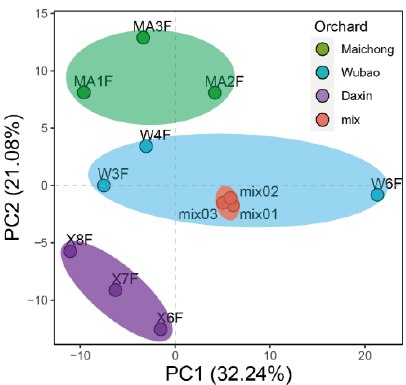
Figure A2. PCA of flavonoid metabolites of peels samples from three orchards. Horizontal ordinate shows PC1 value, and vertical coordinate shows PC2 value. Mix represents sample mix.